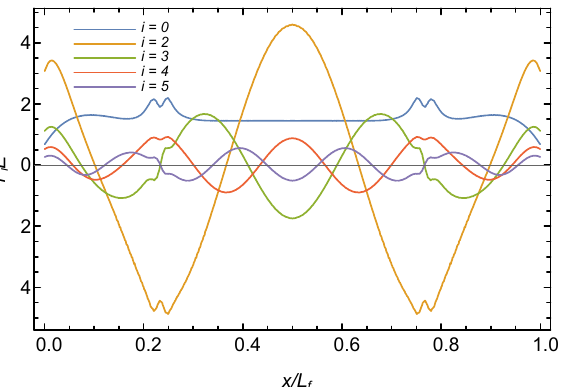
Figure 3. First five modes of Γ functions presented in a normalized